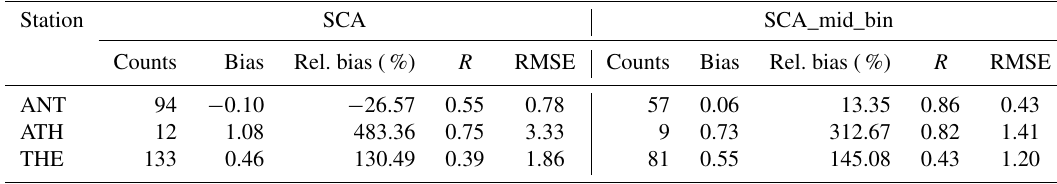
Table 2. As in Table 1 but for the filtered (only aerosols) Aeolus backscatter retrievals (in Mm − 1 sr − 1 ). Station SCA SCA_mid_bin Counts Bias Rel. bias (%) ANT ATH THE